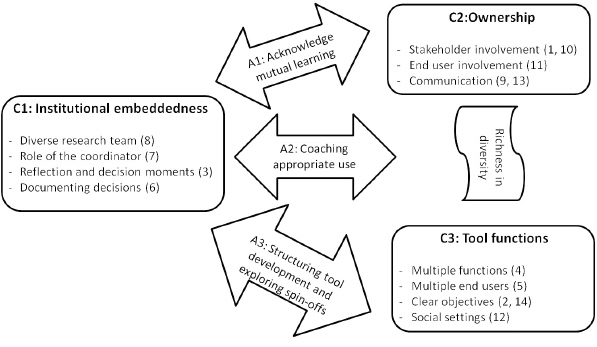
Fig. 4 . Clusters of lessons learned (boxes C1, C2, C3) and their relations (flag: analogy; arrow (A1, A2, A3): actions for